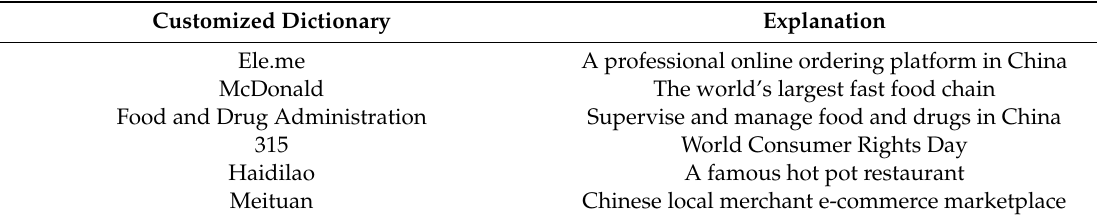
Table 1. Examples of elements in the user-defined dictionary.